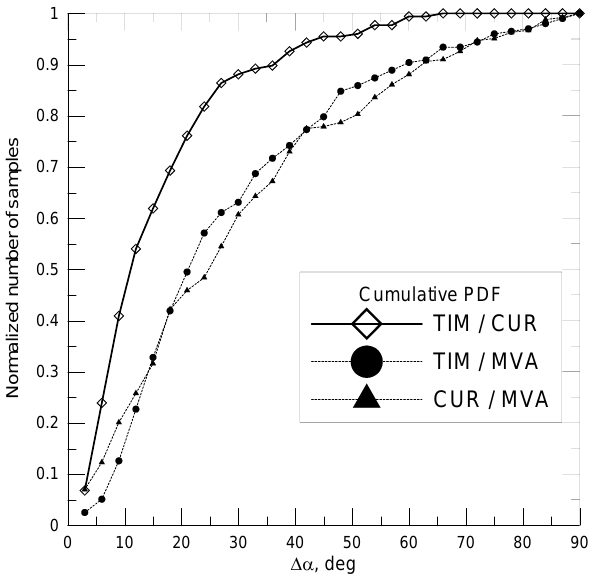
Fig. 1. Cumulative probability distribution function of events with angular difference between two normals (obtained with TIM, CUR or MVA methods) below the given 1α angular difference.